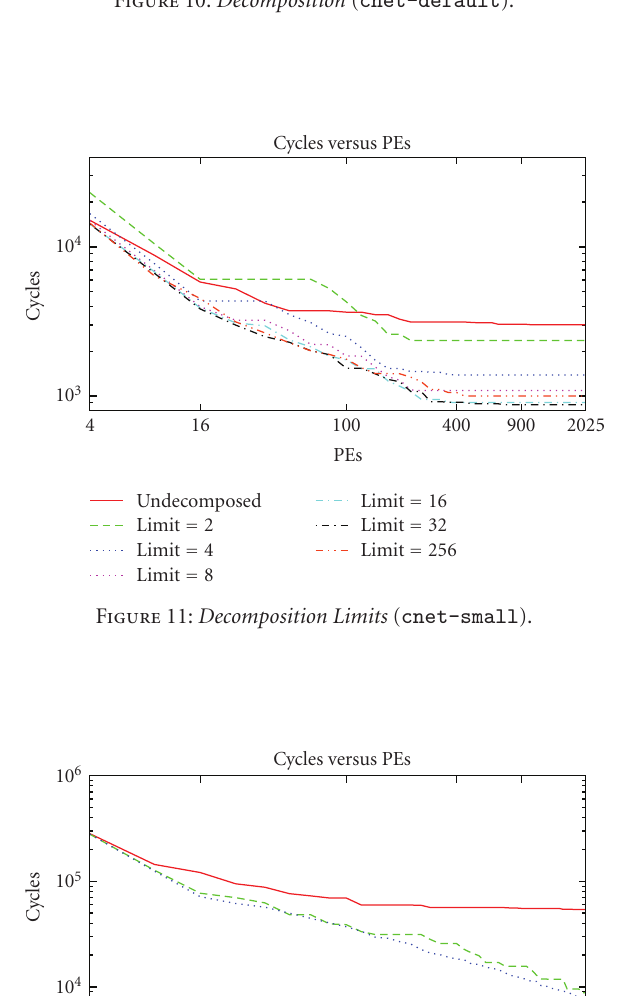
Figure 10: Decomposition ( cnet-default ).